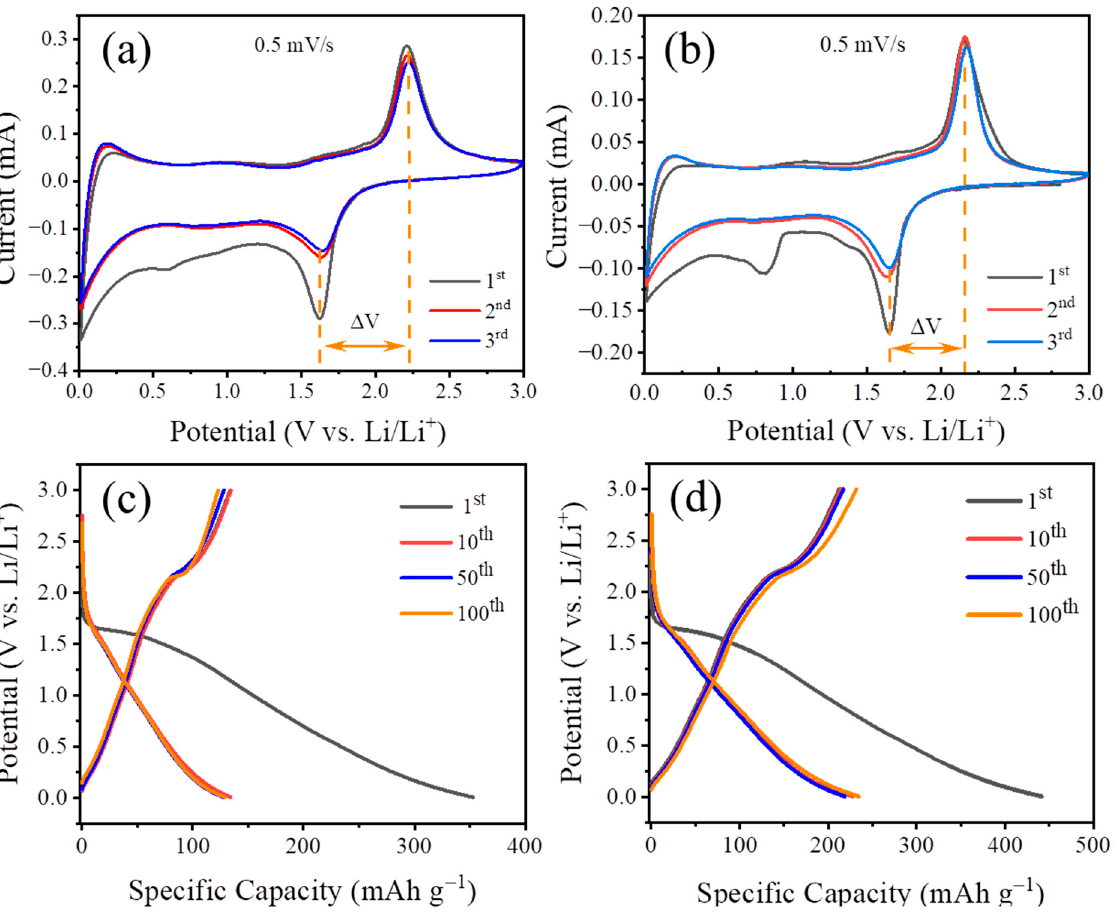
Figure 5. CV curves of the TiO 2 ( a ) and Co@TiO 2 ( b ) electrodes at a scan rate of 0.5 mV s − 1 . Discharge–charge potential profiles of the TiO 2 ( c ) and Co@TiO 2 ( d ) electrodes for the 1st, 10th, 50th, and 100th cycles over the potential window 0.01–3.0 V at 3 C.